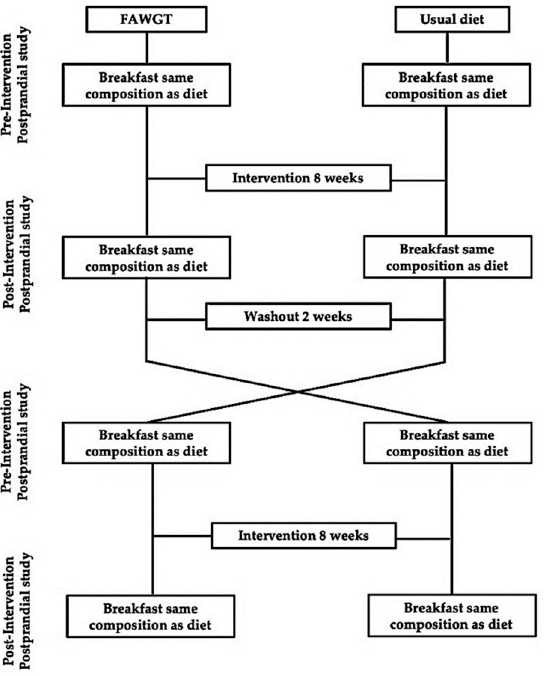
Figure 1. Study design. FAWGT, diet consisting of fruit, avocado, whole grains, and